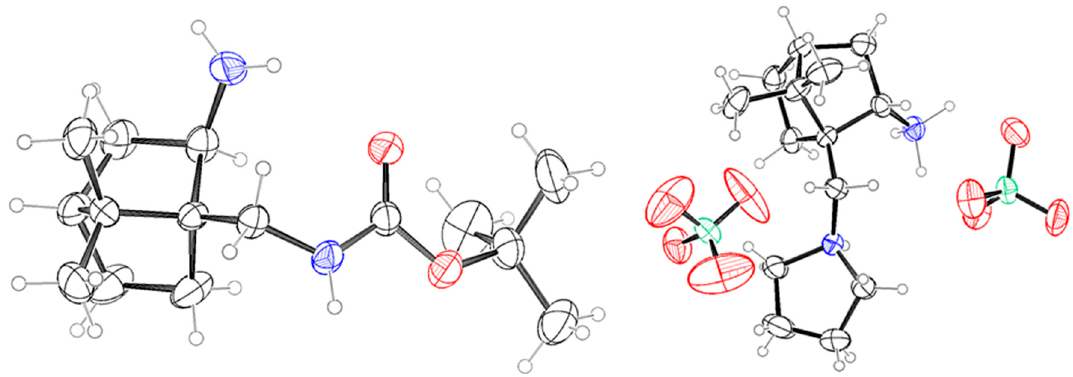
Figure 3. Single-crystal X-ray structures of exo -diamine 29 ( left ) and endo -diamine· 22a ·HClO 4 ( right ).